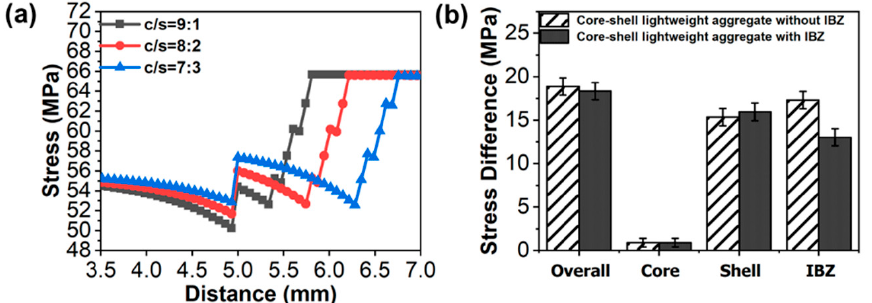
Figure 6. ( a ) Stress distribution curves of PATH I with different core–shell thickness ratios in the presence of bonding zone; and ( b ) Influence of core–shell interface bonding zone on stress difference of each part of the model.